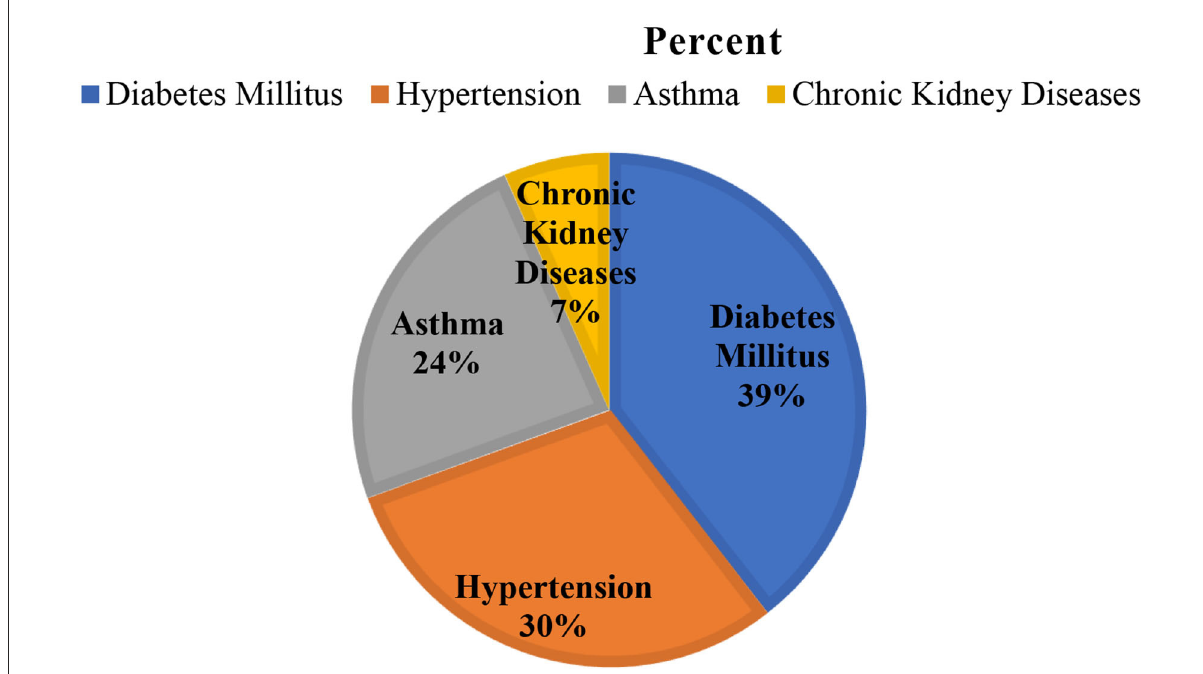
FIGURE1 Chronic diseases of the participants at Jimma town 2021, Jimma, Ethiopia.